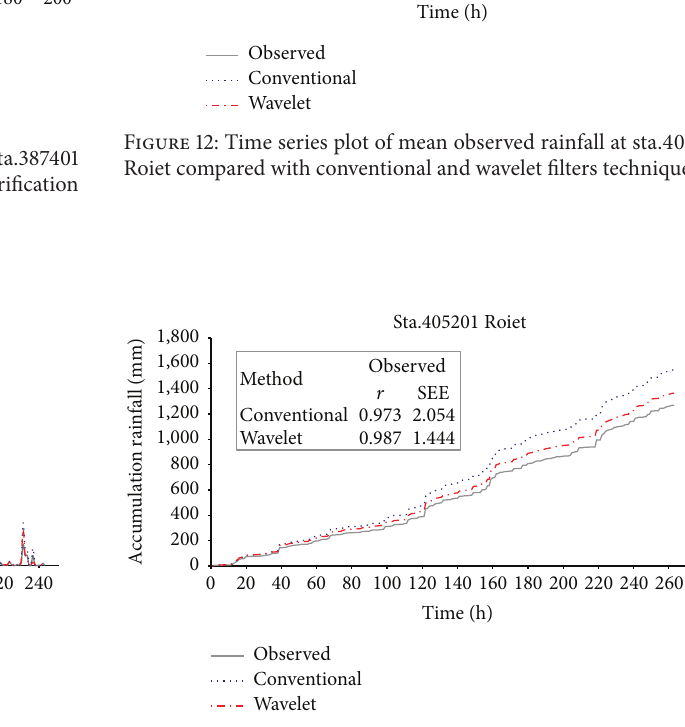
Figure 10: Time series plot of mean observed rainfall at sta.403201 Chaiyaphum compared with conventional and wavelet filters tech- nique.